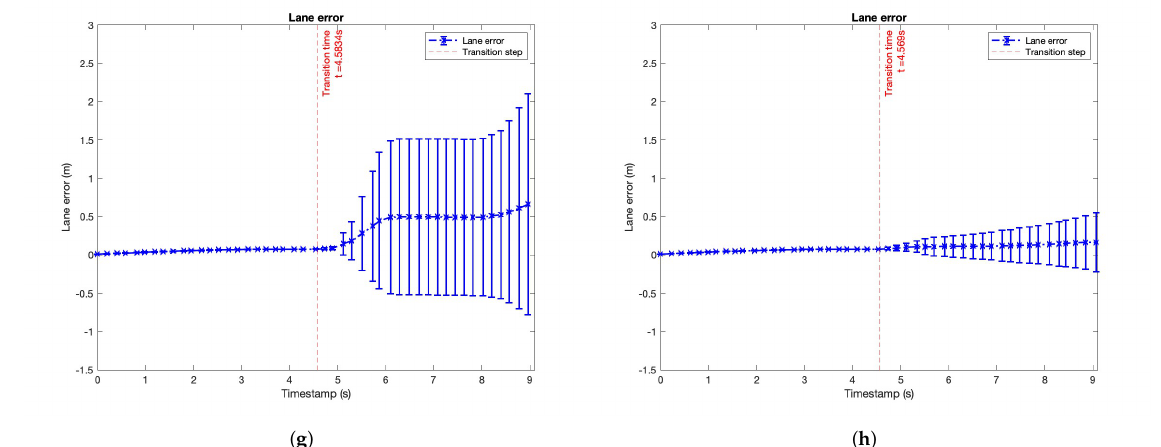
Figure 13. Lane error analysis after transition (mean and standard deviation). Transitions are splitted